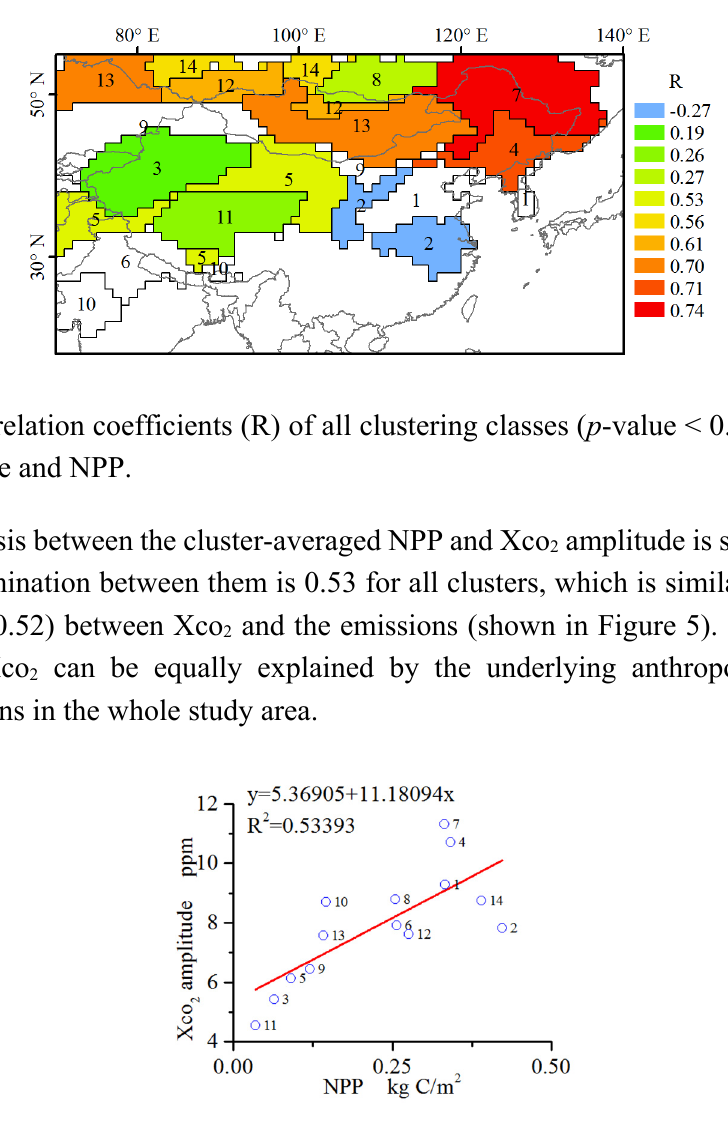
Figure 8. Regression analysis between cluster-averaged NPP and Xco